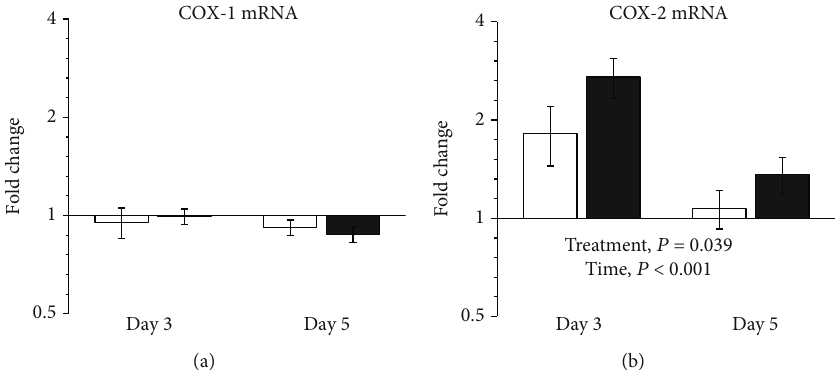
Figure 5: COX-1 (a) and COX-2 (b) mRNA levels in anastomotic wounds on days 3 and 5 were normalized to RPLP0 and are shown as fold changes relative to the noninjured colon of vehicle-treated rats on day 0. Open bars: vehicle; fi lled bars: ZP1849. Geometric mean ± back ‐ transformed